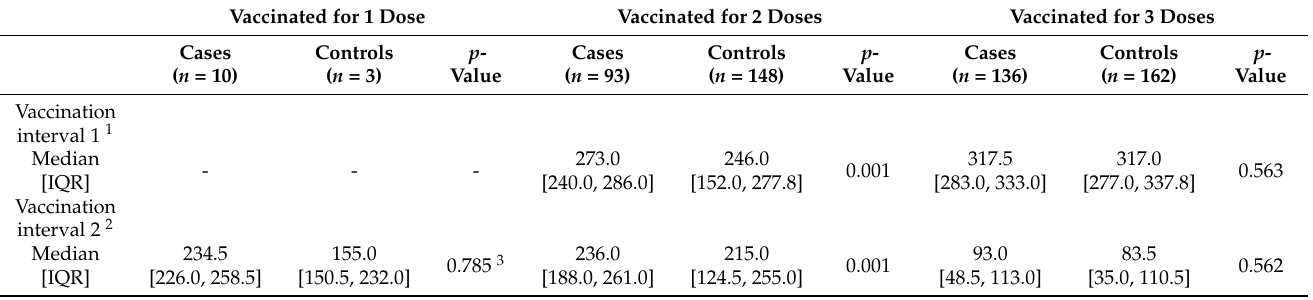
Table 3. Vaccination intervals of case and control groups who had been vaccinated ( n =